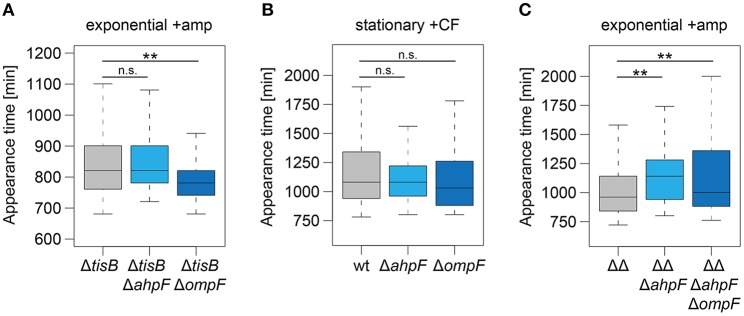
The role of AhpF and OmpF in TisB-independent persisters and synergistic effects. Deletions of ahpF and ompF were constructed in a tisB deletion (ΔtisB), wild-type (wt), or Δ1-41 ΔistR (ΔΔ) background. Resulting strains were analyzed by ScanLag. (A) Cultures were treated with ampicillin (+amp; 200 μg ml−1) for 3 h during exponential phase. Boxplots reflect appearance time distributions for ΔtisB (n = 394), ΔtisB ΔahpF (n = 204), and ΔtisB ΔompF (n = 272). (B) Cultures were treated with ciprofloxacin (+CF; 10 μg ml−1) for 5 h during stationary phase. Boxplots reflect appearance time distributions for wt (n = 113), ΔahpF (n = 147), and ΔompF (n = 58). (C) Cultures were treated with ampicillin (+amp; 200 μg ml−1) for 3 h during exponential phase. Boxplots reflect appearance time distributions for ΔΔ (n = 325), ΔΔΔahpF (n = 233), and ΔΔΔahpFΔompF (n = 142). P-values were calculated using Mann–Whitney-Wilcoxon test (**P < 0.01; n.s., not significant).